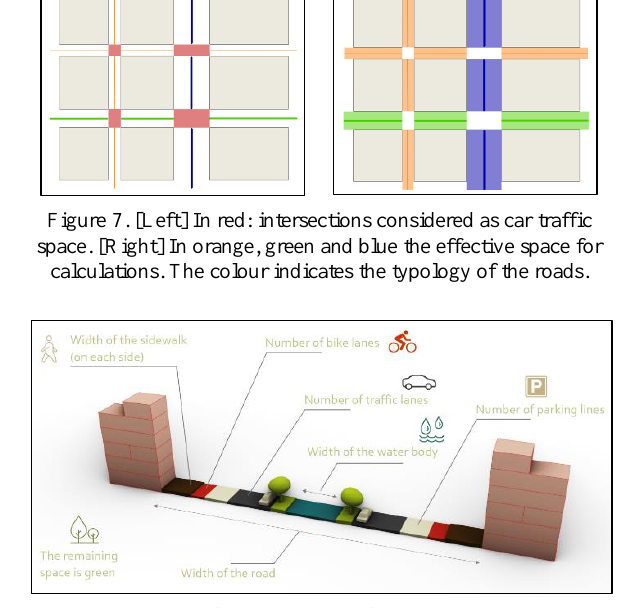
Figure 8. Section of possible layout for outdoor spaces.